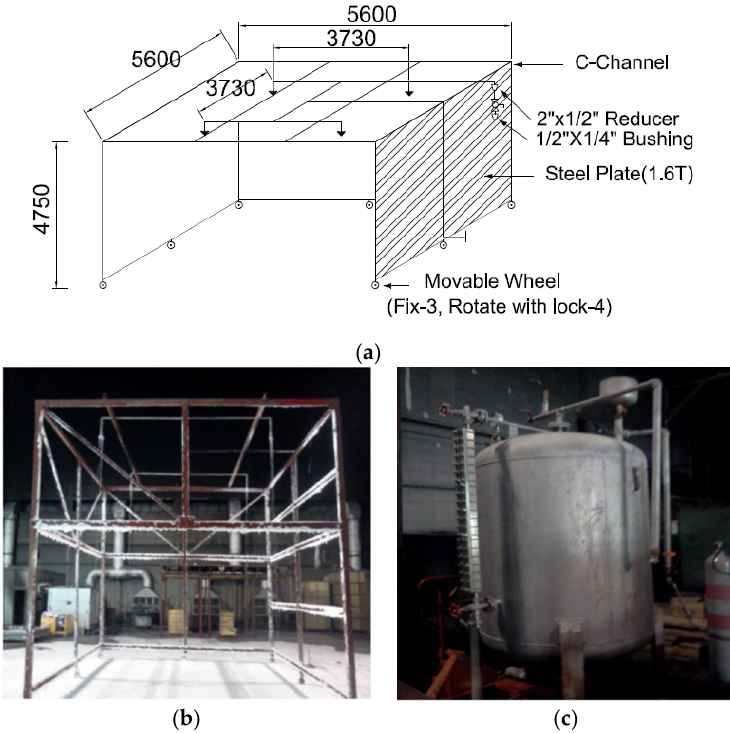
Figure 2. Prototype fire ‐ extinguishing performance appraisal test equipment and details of the compressed air foam system. ( a ) Experimental set ‐ up details; ( b ) Experimental frame; ( c ) Storage tank of the foam aqueous solution.